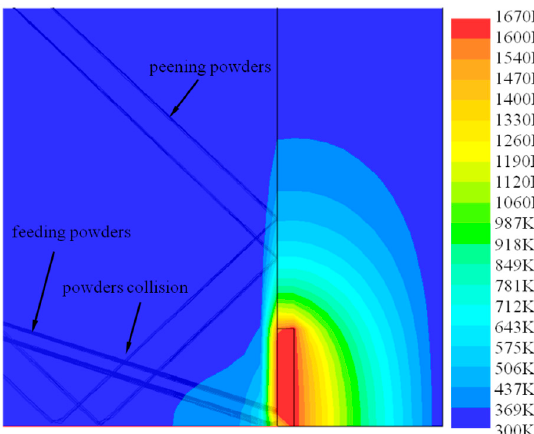
Figure 10. The distribution of the powder flow and the temperature field under the optimal injection point.